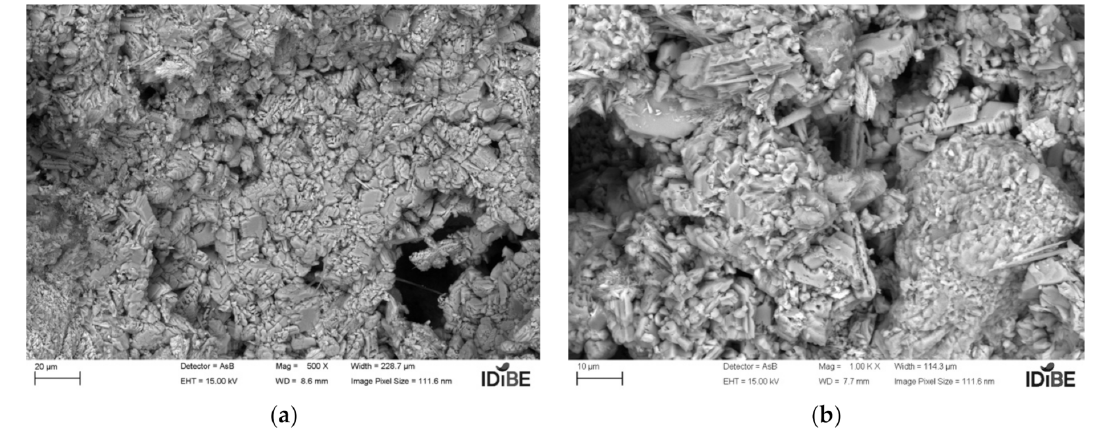
Figure 14. Micrograph of the 1.2% polycarboxylate compound (lot VS3): ( a ) 20 µ m; ( b ) 10 µ m (source: the author).